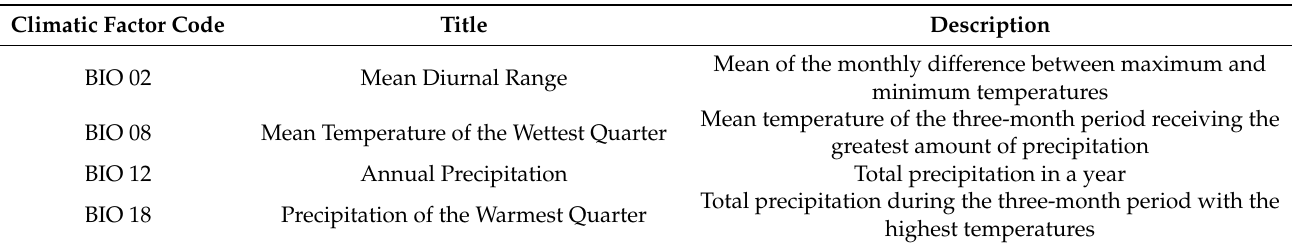
Table 1. Climatic factors downloaded from WorldClim (www.worldclim.org/, accessed on 8 April 2020) and used to model potential distribution of nine-banded armadillos in southern Illinois during 2016–2020. Bioclimatic variables represented annual trends, seasonality, and extreme or limiting environmental factors. Climatic Factor